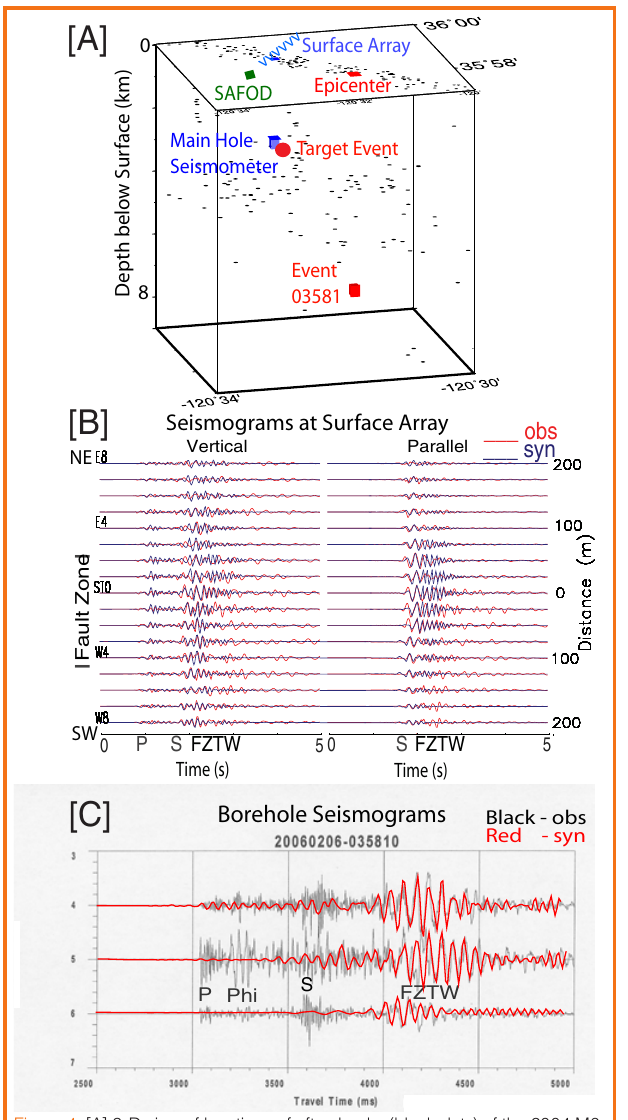
Figure 4. [A] 3-D view of locations of aftershocks (black dots) of the 2004 M6 Parkfield earthquake recorded at the SAFOD mainhole seismograph (blue square). The red square denotes an example event (03581) occurring at ~6 km depth within the fault zone with its epicenter ~3 km SE of the